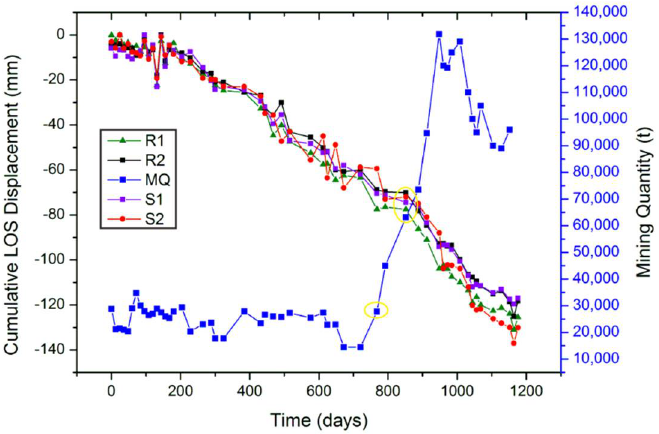
Figure 21. The cumulative LOS subsidence displacement and mining quantity change (the turning points of subsidence displacement and mining quantity are circled by yellow ellipses).